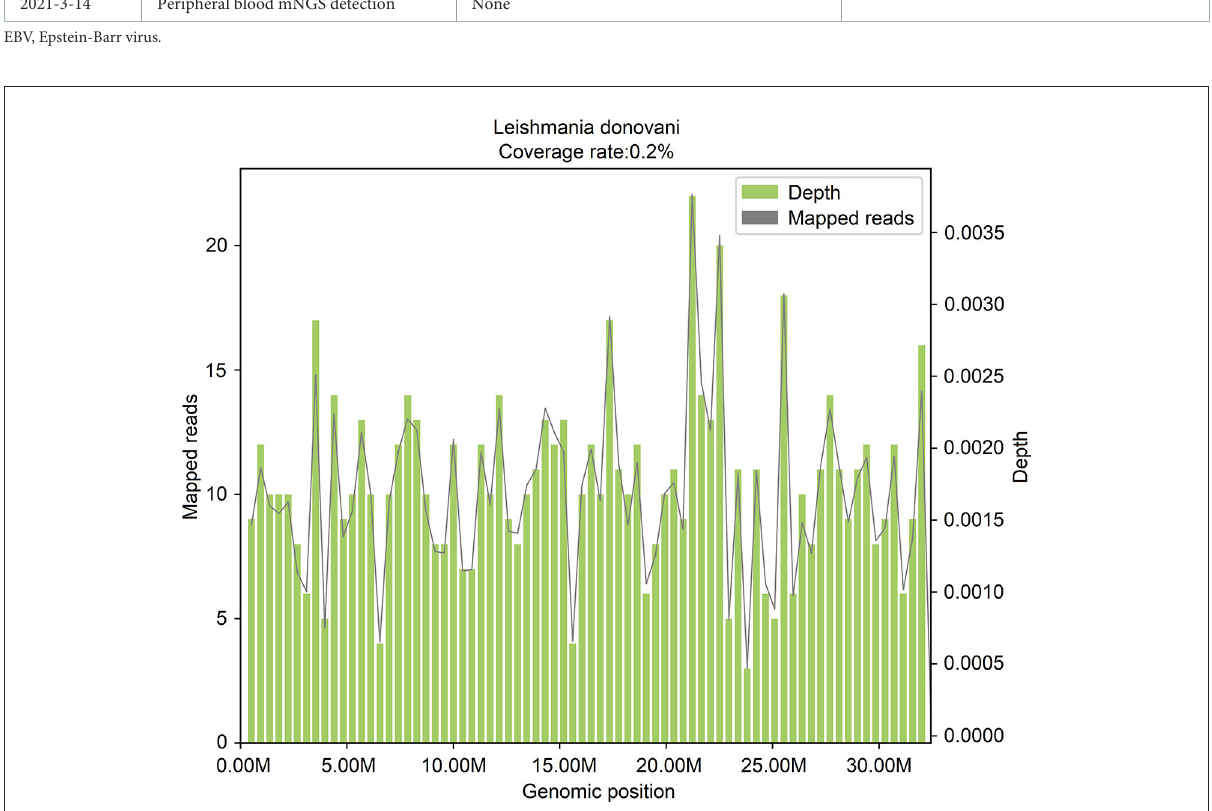
FIGURE2 The genome coverage map of Leishmania donovani detected by mNGS in case 2. The genome coverage of Leishmania donovani in the peripheral blood of case 2 is